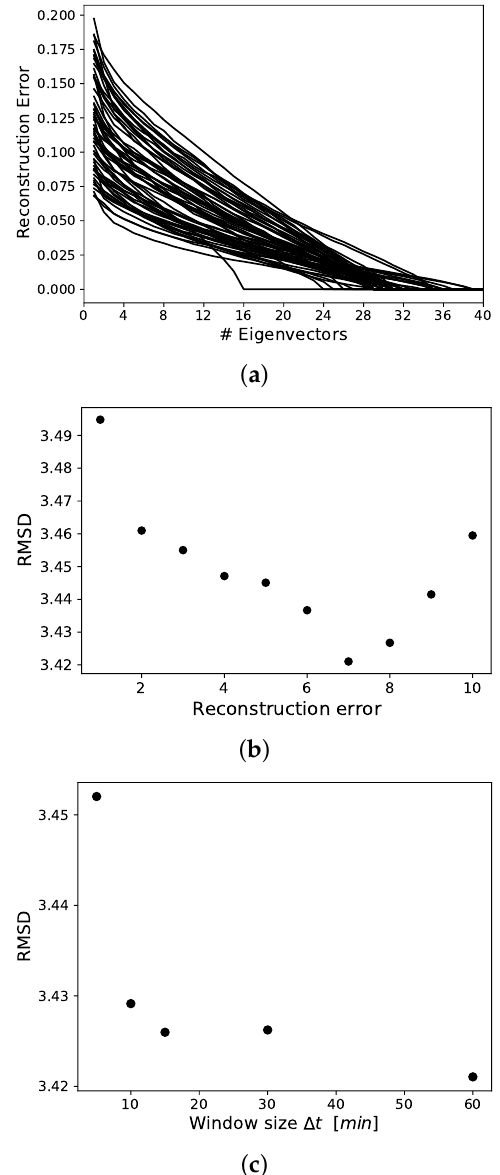
Figure 3. In ( a ), the normalized reconstruction error for increasing numbers of used eigenvectors is depicted. In ( b ), the RMSD of a linear regression for different reconstruction errors is shown. In ( c ), the optimal window size ∆ t is evaluated. The lowest RMSD is obtained at ∆ t = 60 min ↔ S =